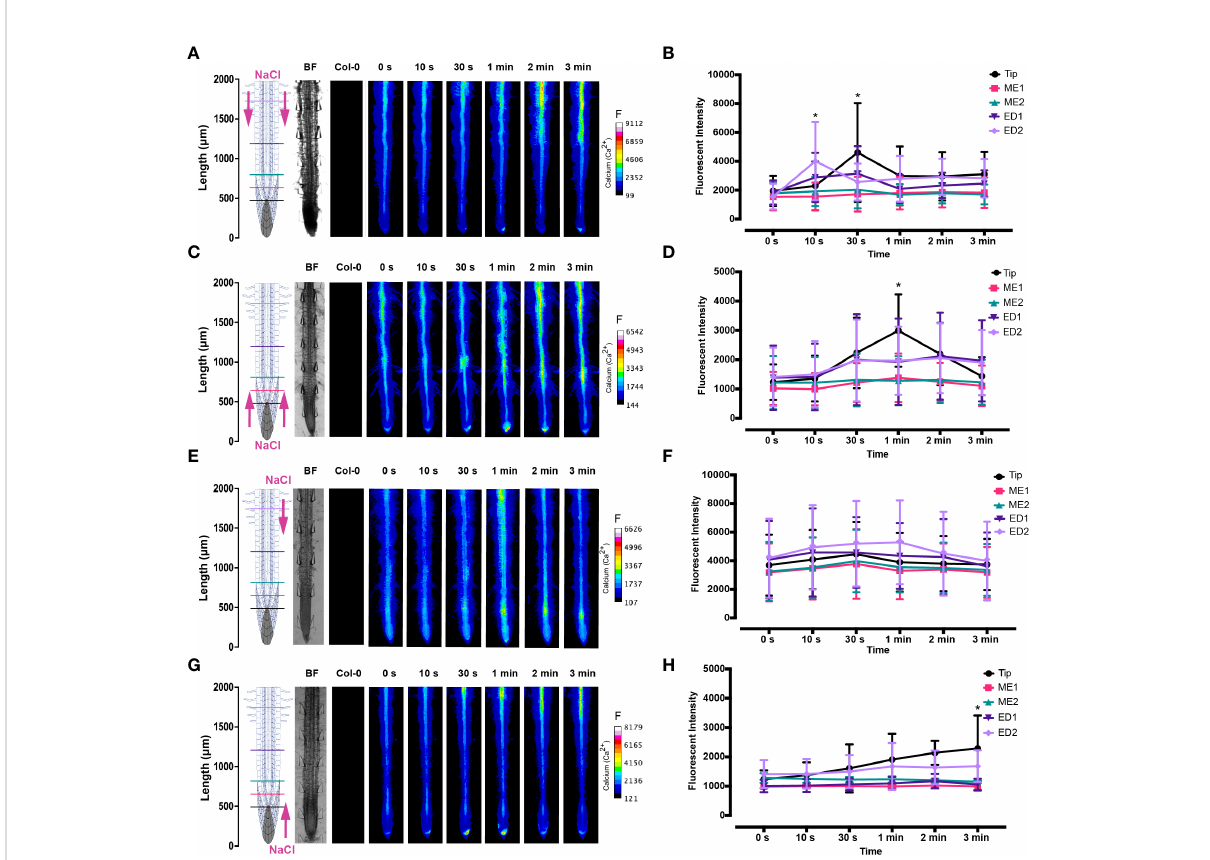
FIGURE 3 Fluorescence intensity of Ca 2+ in Arabidopsis G-CaMP3 roots exposed to NaCl (100 mM). Fluorescence was observed for 180 s post NaCl treatment. (A) Heat map depicting Ca 2+ release, corresponding to increase in G-CaMP3 fl uorescence. Five linear sections used for fl uorescence quanti fi cation upon targeted application of NaCl treatment through inlets A (left) & B (right) at the differentiation zone (DZ) are shown (n= 10). Colour change indicates an increase in Ca 2+ fl uorescence. Root schematic depicting treatment application, orientation (salt; NaCl and control; MS media) and linear sections (refer to key), bright fi eld (BF) and control (wild type Col-0) roots displayed on the left. Scale; F= fl uorescence intensity. (B) Line graph with two-way ANOVA multiple comparisons Tukey ’ s honestly signi fi cant difference (HSD) mean comparison test (P-value ≤ 0.05) depicting average fl uorescence intensity (ADU; analogue digital units) of Ca 2+ across fi ve linear sections (Tip, ME1, ME2, ED1 & ED2) upon targeted exposure of salt treatment through inlets A & B at the DZ (n = 10). Asterisks (*) indicate statistical signi fi cance. (C) Heat map depicting Ca 2+ release, and corresponding increase in G-CaMP3 fl uorescence, upon salt treatment through inlets C (left) & D (right) at the tip (n= 10). (D) Line graph depicting average fl uorescence intensity of Ca 2+ across fi ve linear sections following salt treatment through inlets C & D at the tip (n= 10). (E) Heat map depicting Ca 2+ release, and corresponding increase in G-CaMP3 fl uorescence, upon salt treatment through inlet B and control media through inlet A at the DZ (n= 10). (F) Line graph depicting average fl uorescence intensity of Ca 2+ across fi ve linear sections following salt treatment through inlet B and control treatment through inlet A at the DZ (n= 10). (G) Heat map depicting Ca 2+ release, and corresponding increase in G-CaMP3 fl uorescence, upon salt treatment through inlet D and control treatment through inlet C at the tip (n=